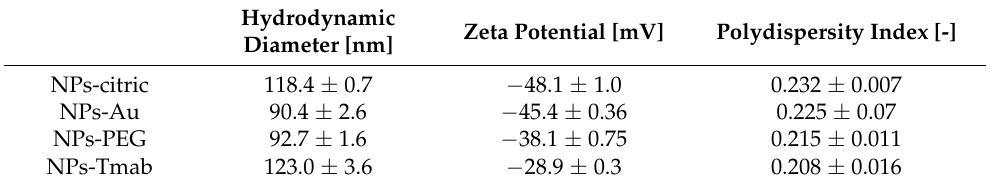
Figure 1. Transmission Electron Microscopy images of ( a ) citrate stabilized NPs, ( b ) NPs-Au, ( c ) NPs-PEG, and ( d ) NPs-Tmab. Table 1. Values of hydrodynamic diameter, zeta potential and PI of NPs measured in